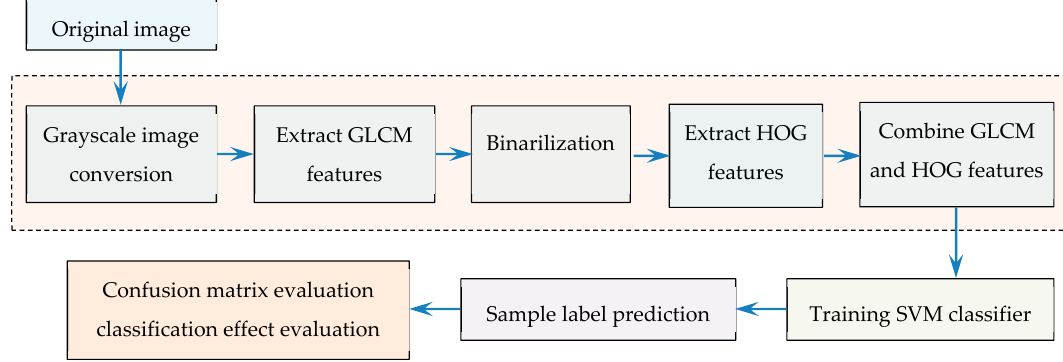
Figure 2. Flow diagram of support vector machine (SVM) image processing classification algorithm. HOG, histogram of oriented gradients; GLCM, gray-level co-occurrence matrix.